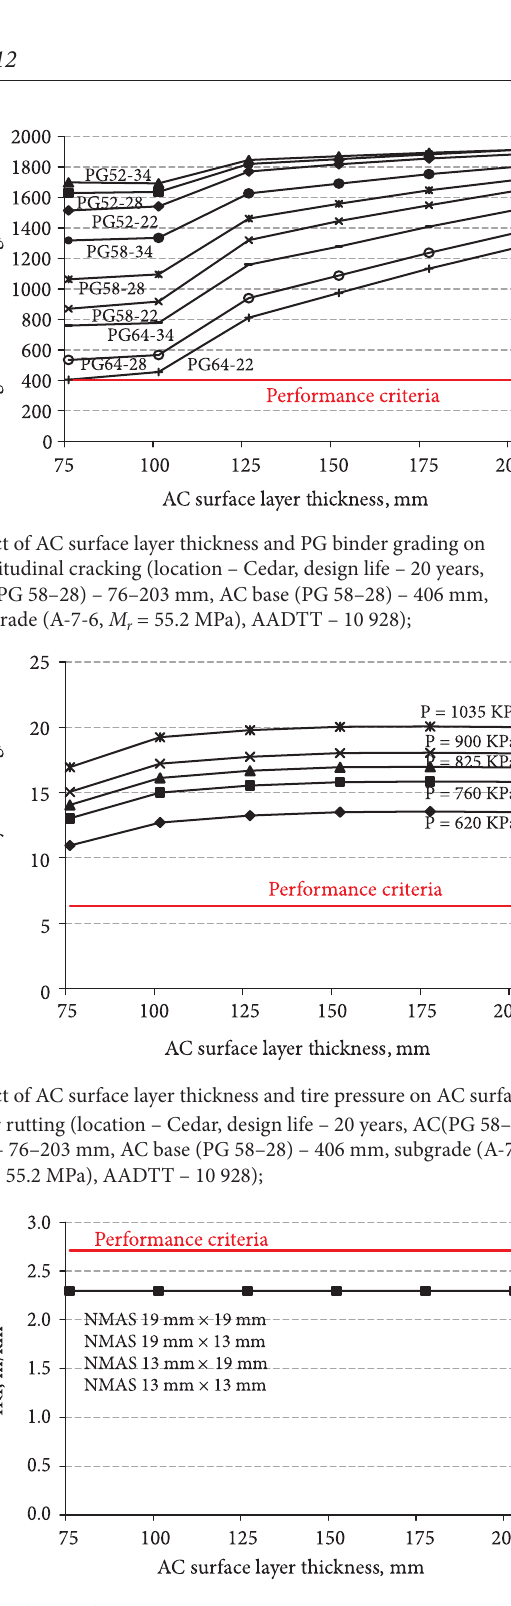
fig. 1. Effect of input parameters on AC longitudinal cracking – examples for different levels of sensitivity